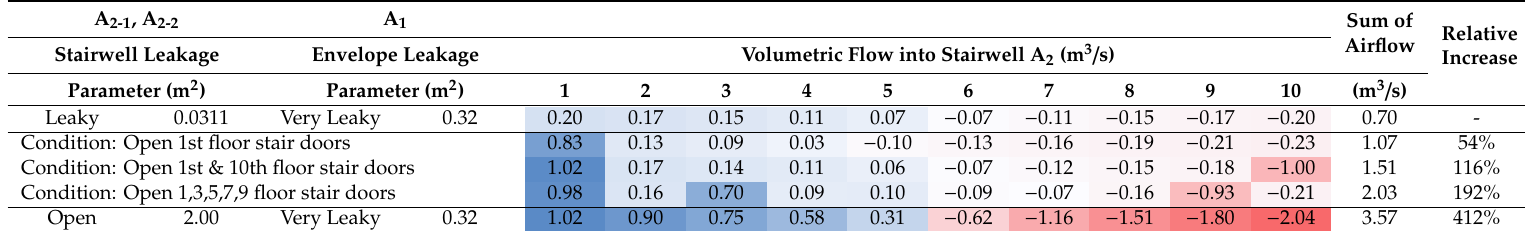
Table 6. Airflow into stairwells for conditions with stairwell doors